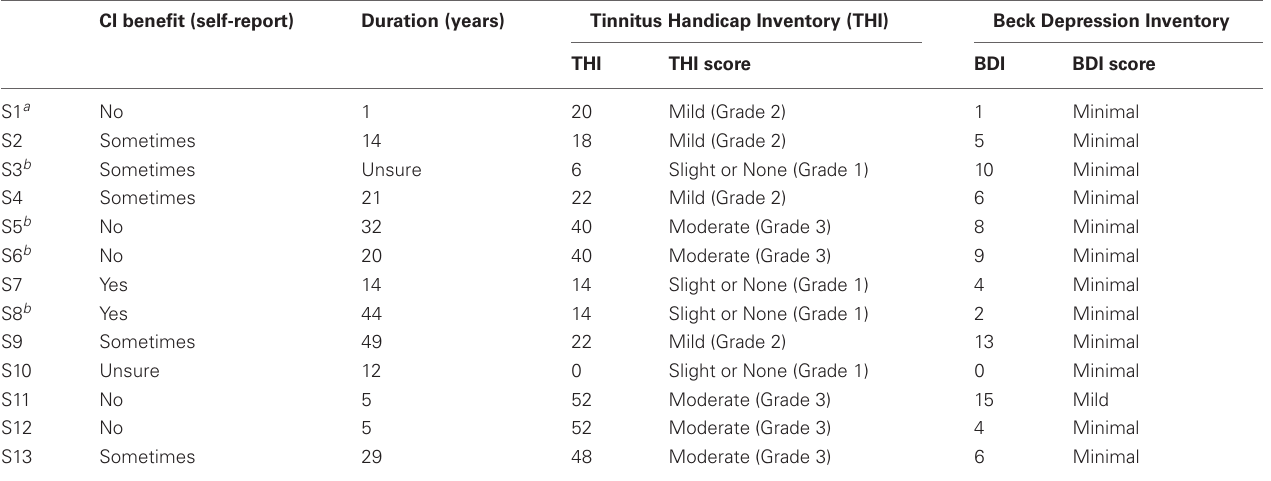
Table 2 | Patient tinnitus